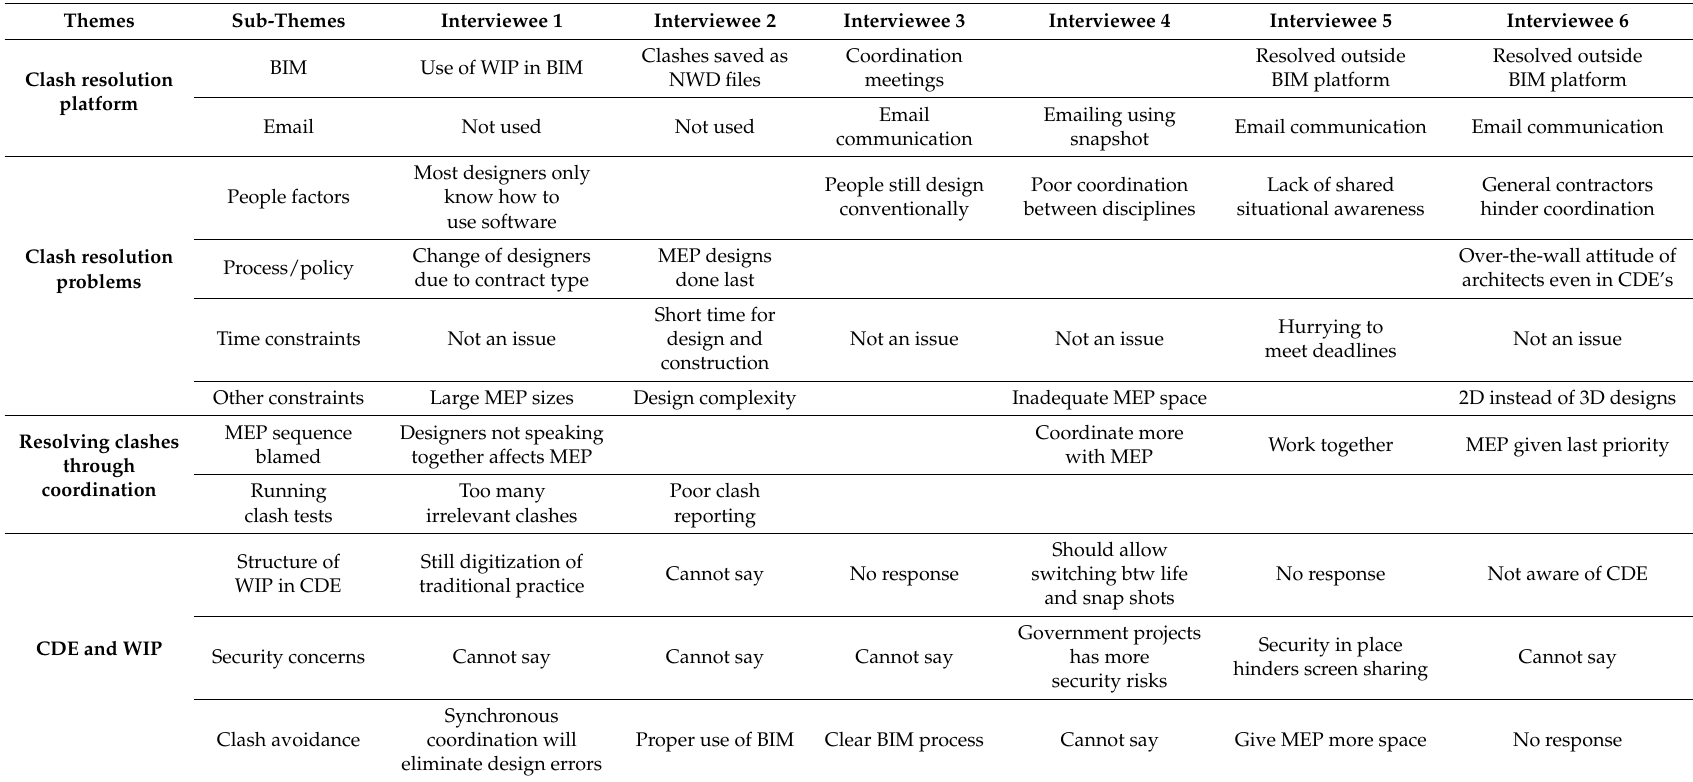
Table 8. Thematic summary of the interview